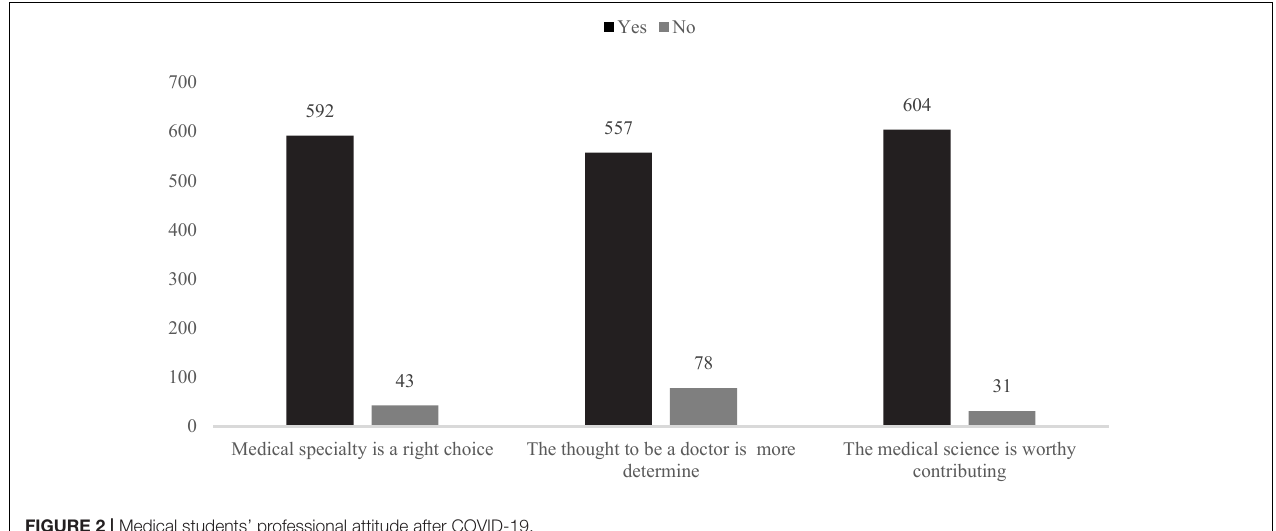
FIGURE 2 | Medical students’ professional attitude after COVID-19.